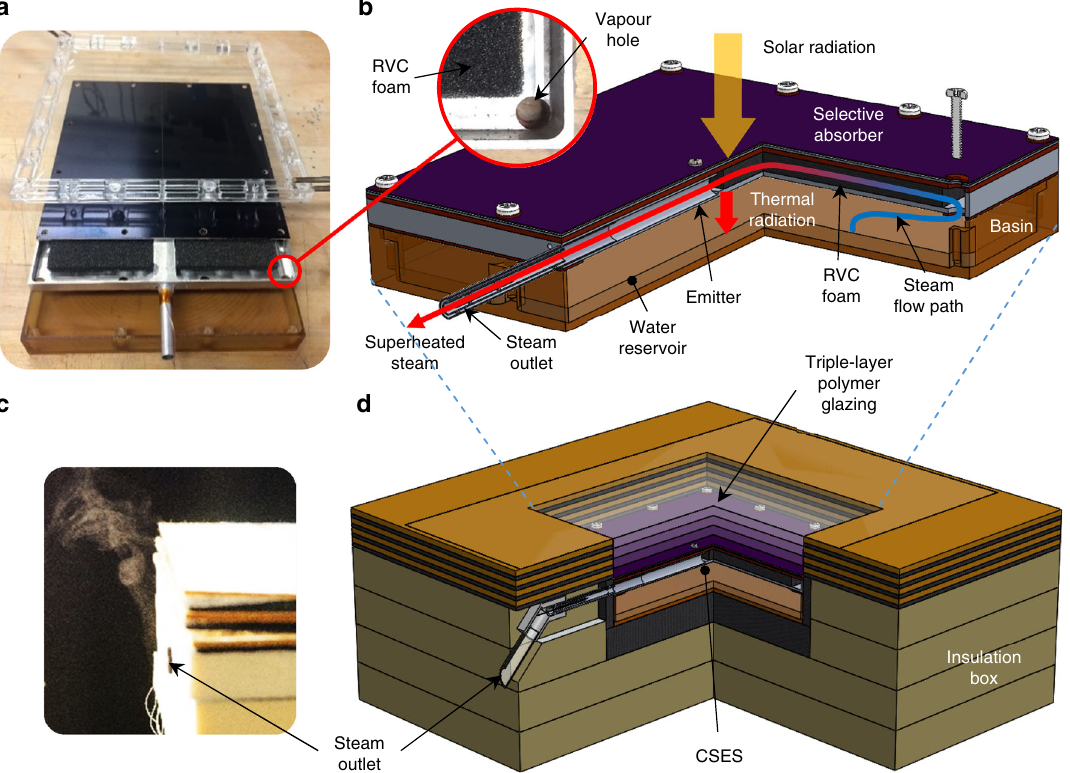
Fig. 2 Laboratory-scale contactless solar evaporation structure (CSES). a Photograph of disassembled CSES device. b Cutaway schematic of CSES device showing the main components and steam fl ow path. c Photograph of steam generated by the CSES at one sun illumination. d Cutaway schematic of the laboratory